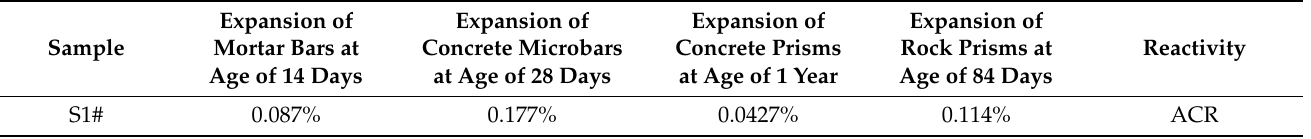
Table 4. Alkali-reactivities of dolomitic limestone S1# based on results of ASTM C1260, RILEM AAR-5, ASTM C1293, and ASTM C586.